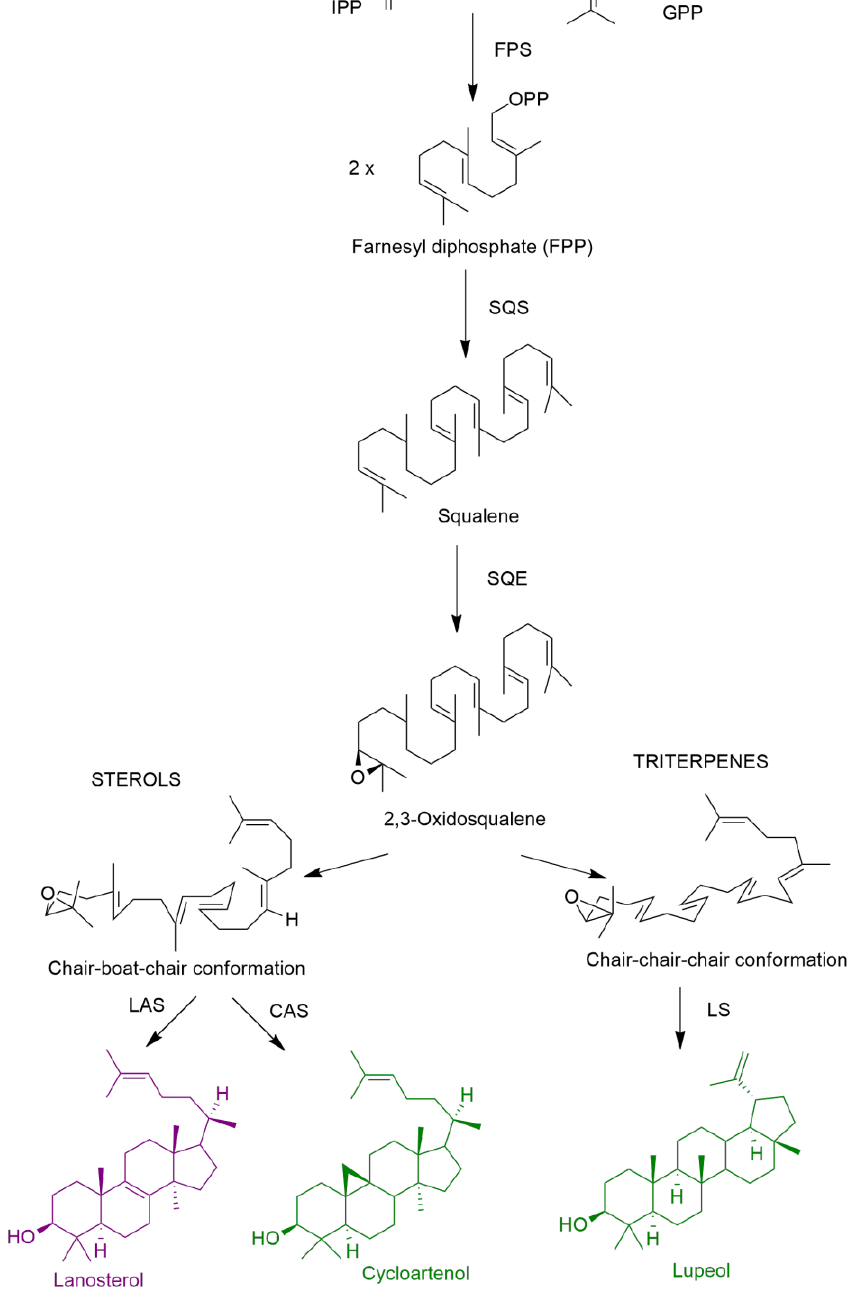
Figure 8. Schematic biosynthesis of sterols and triterpenes. CAS: cycloartenol synthase; FPS: far- nesyl diphosphate synthase; GPP: geranyl diphosphate; LAS: lanosterol synthase; LS: lupeol synthase; IPP: isopentenyl diphosphate; SQE: squalene monooxygenase or epoxidase; SQS: squalene syntase (adapted from [35]).